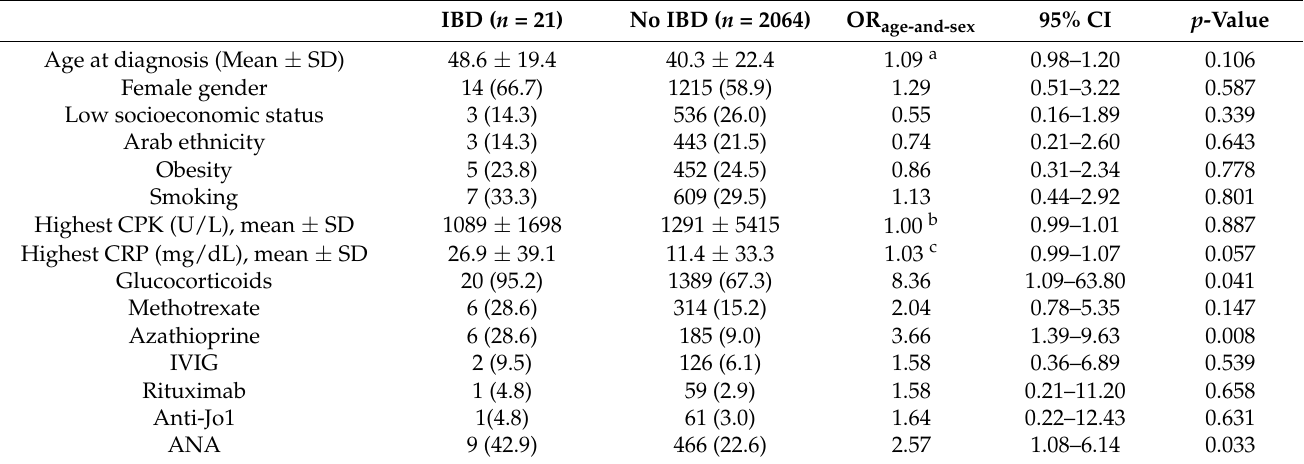
Table 3. Predictors of IBD among patients with